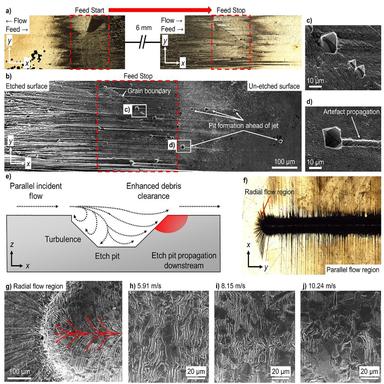
Striations propagate from pits ahead of the jet. Translation and electrolyte flow follow axis 'x'. a) Optical micrographs showing jet termination regions after single pass processing. b) SE micrographs showing the nucleation of pit features on discontinuities, c) like grain boundaries. d) Striations propagate from these pits, parallel to the electrolyte flow, ahead of the jet. e) Flow is more complex within pits than flat surfaces generating differential flow conditions downstream of the pit where greater f